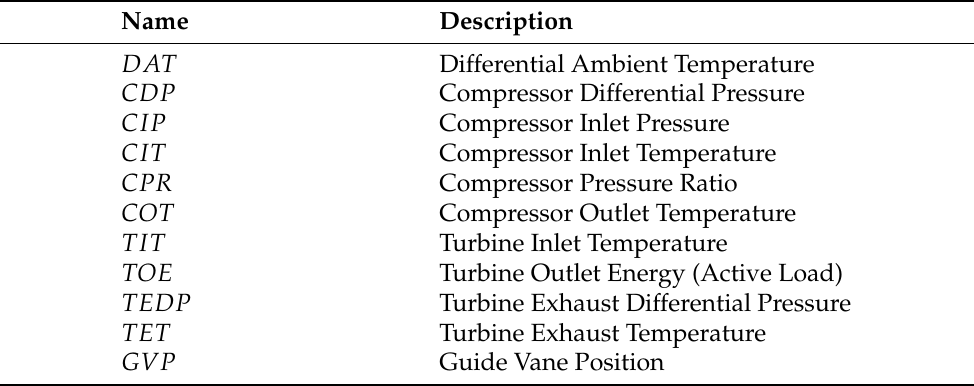
Table 2. Feature set used for